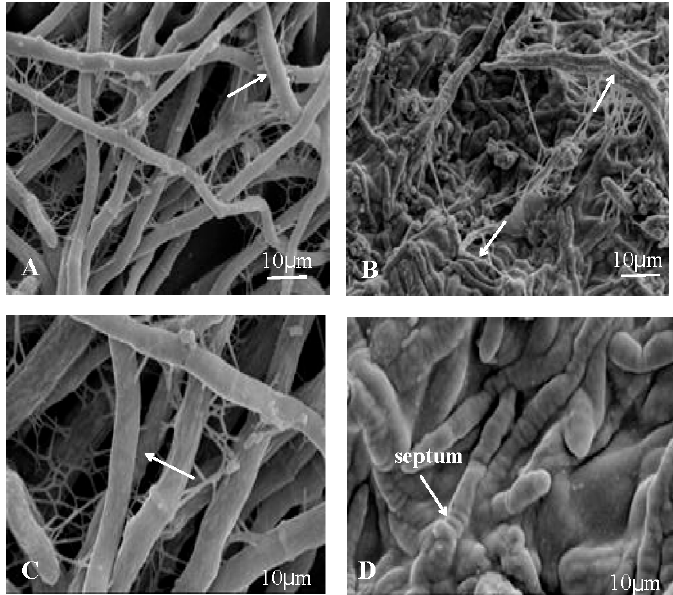
Figure 7. Scanning electron microscopy images of untreated and treated V. mali hyphal structure. The untreated hypha appeared round and plump, with structural integrity. ( A ) 800×; ( C ) 3000×. After treatment with 40 µ g/mL (working concentration) cembranoids extract, the hypha was deformed, showing adhesion and obvious septa. ( B ) 800×; ( D ) 3000×.